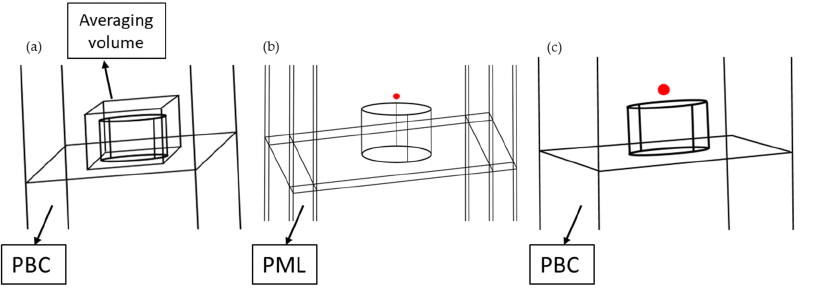
Figure 2. Schematic representation of geometries used for computing the three factors separately. ( a ) Square volume surrounding the NS to compute the average electric field enhancement with Floquet-type periodic boundary conditions (PBC) around. ( b ) Dipole above the nanostructure surrounded with perfectly matched layers (PMLS) to compute the quantum yield enhancement of the fluorophore. ( c ) Dipole above the NS, to compute the far field radiation pattern. After excitation, the fluorophore can return to its ground state, emitting a photon at a longer wavelength λ em or decaying non-radiatively. This phenomenon is characterized